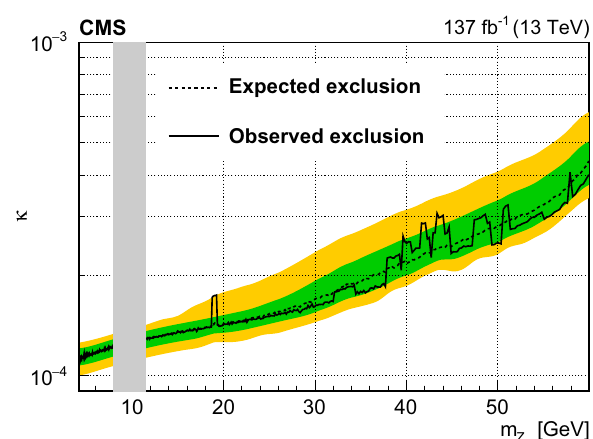
Fig. 6 95% CL limits on the Higgs-mixing parameter κ , based on the XX selection, as function of m Z . The dashed black curve is the D expected upper limit, with one and two standard-deviation bands shown in green and yellow, respectively. The solid black curve is the observed upper limit. The grey band corresponds to the excluded region around the bb bound states of Υ